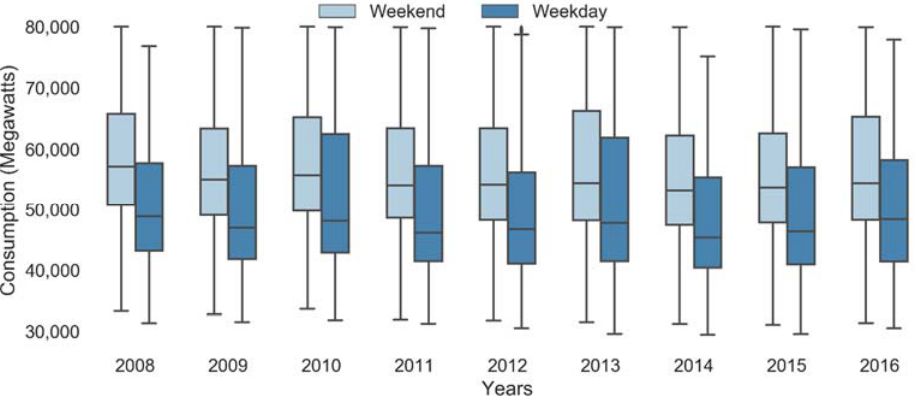
Figure 6. Box Plot of Electric Load Consumption Weekend vs. Weekday.